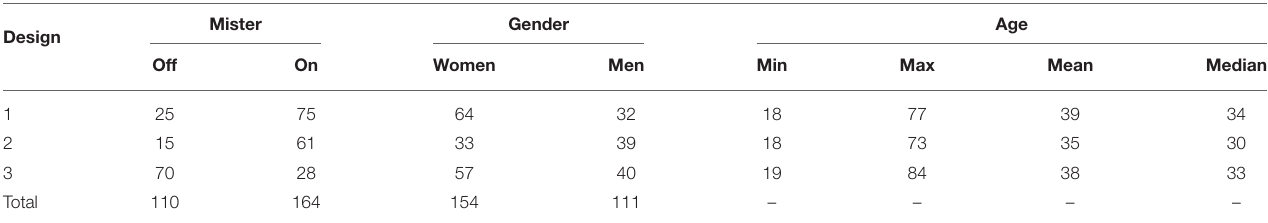
TABLE 4 | Number of questionnaires completed by respondents for each design showing the mister status and gender and age distribution.